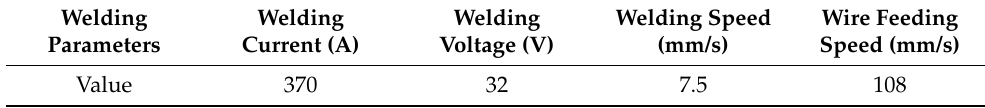
Table 3. Welding parameter